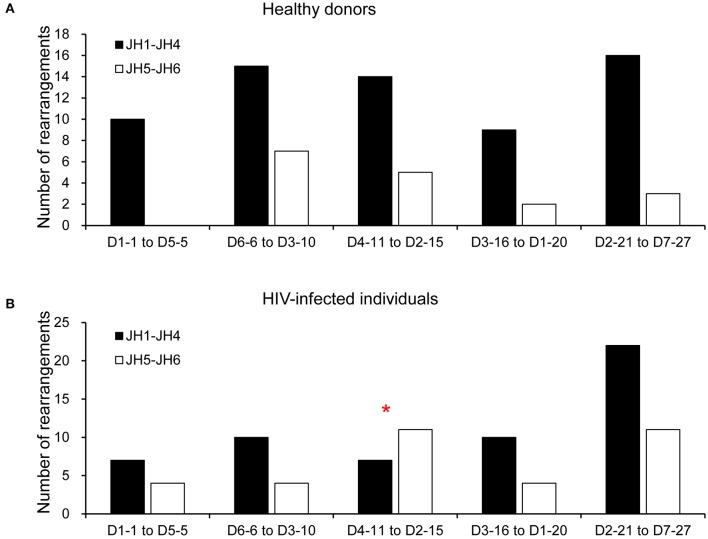
Pairing of IGHD and IGHJ segments in the non-productive repertoire of healthy donors (A) and HIVDs (B). Black bars indicate D proximal JH genes (JH1, JH2, JH3, and JH4), and gray bars indicate D distal JH genes (JH5 and JH6). The D genes are divided into five groups according to their position in the locus (D1-1 to D5-5 are the most JH distal, and D2-21 to D7-27 are the most JH proximal). Only the 81 rearrangements from HDs and 90 rearrangements from HIVDs for which a D segment could be assigned were analyzed. * Significant (p < 0.05) difference when compared with controls.